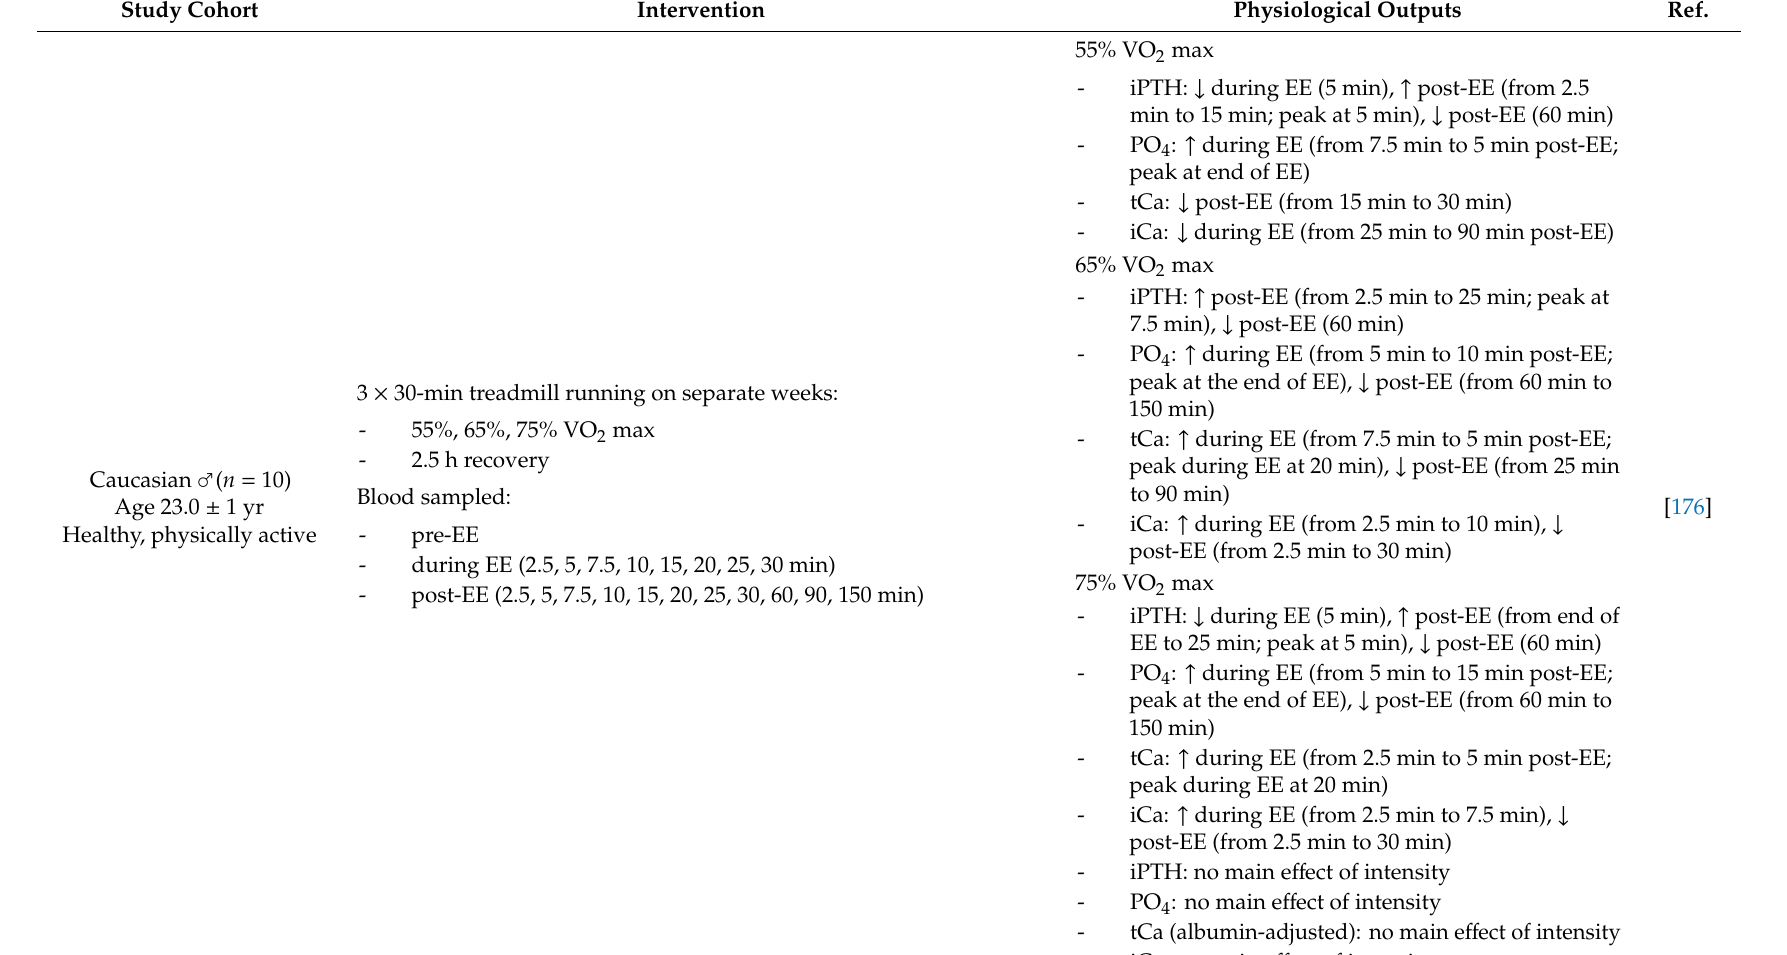
Table 2. Cont . Study Cohort Intervention Physiological Outputs